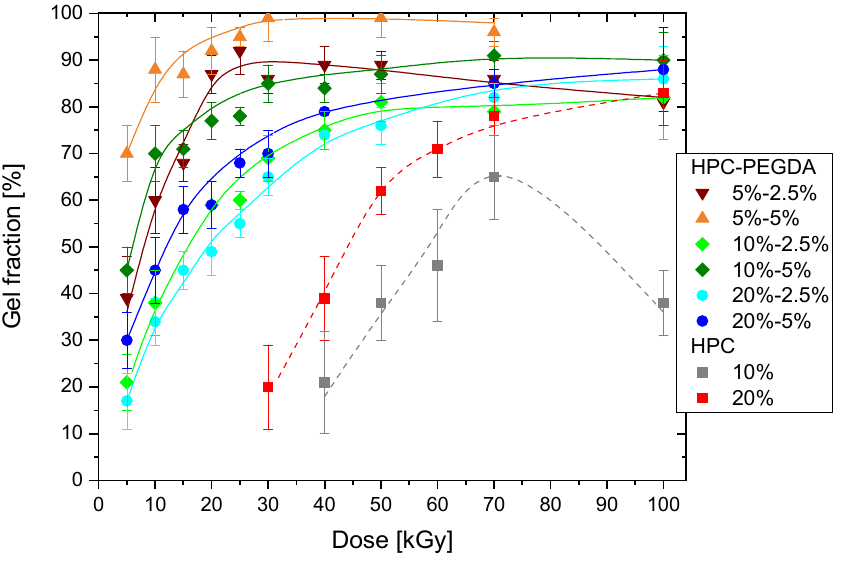
Figure 1. The gel fraction of hydrogels manufactured by the irradiation of HPC and HPC–PEGDA in aqueous solutions.